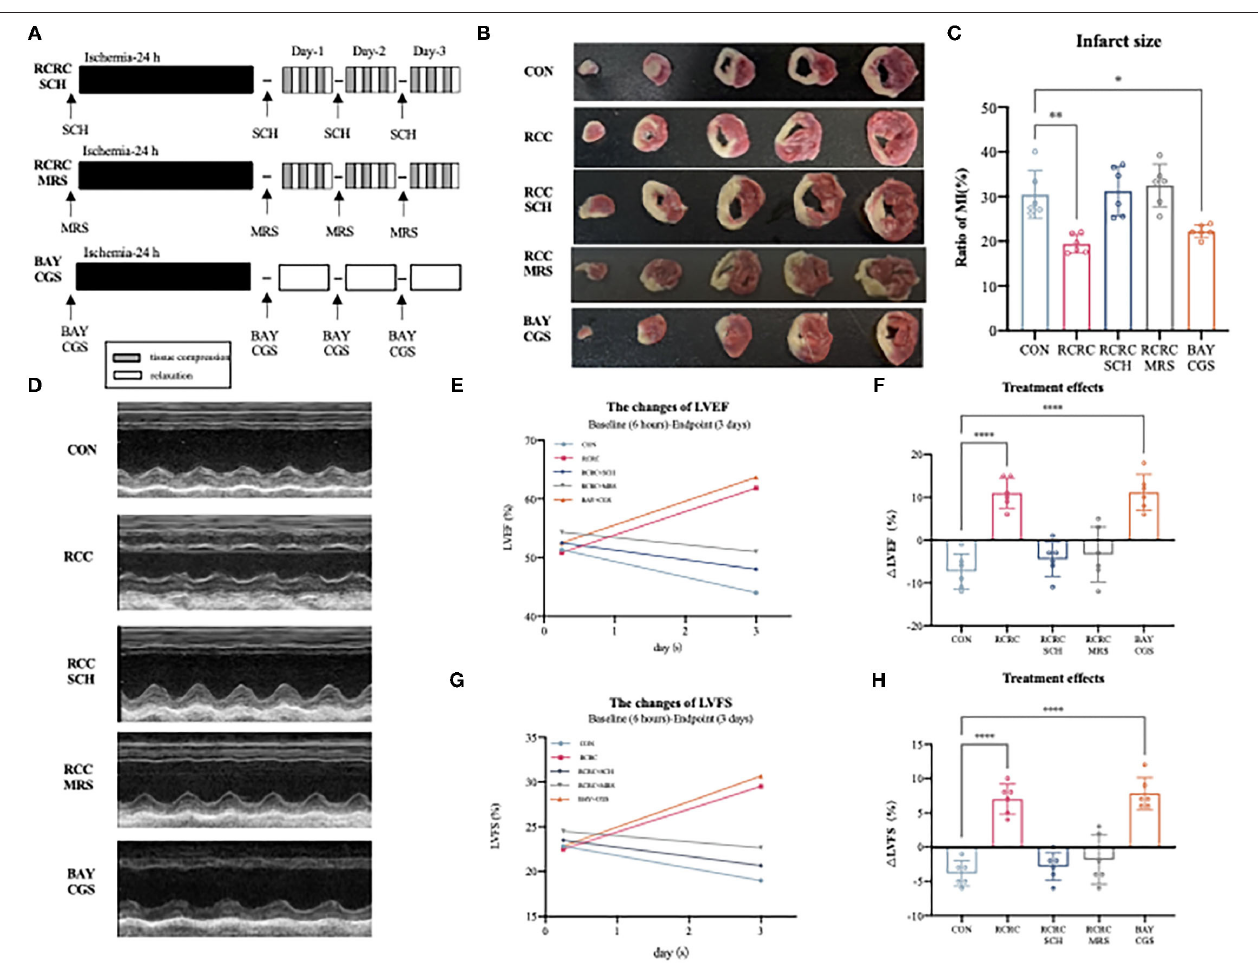
FIGURE 6 | Cardioprotection of remote conditioning by rhythmic compression is lost in SCH or MRS treated rats and mimicked by BAY and CGS treatment. (A) Schematic diagram of the experimental design. RCRC group were treated with the selective A2a antagonist SCH 58261, the selective A2b antagonist MRS 1706; CON group treated with the selective A2a agonist CGS21680 and the selective agonist A2b agonist BAY 60-6583. (B,C) TTC staining representing infarct area on multiples slices of an infarct rat heart and quantitative analyses of infarct size after 3 days of remote conditioning in combination with A2a and A2b receptor blockage and activation, N = 6. (D–H) Representative M-mode echocardiographic images showing LV wall motion of the hearts, the treatment effect was calculated as the changes of LVEFs and LVFSs from baseline to endpoint in combination with A2a and A2b receptor blockage and activation. All values represent as means ± SD. N = 6. * p < 0.05, ** p < 0.01, **** p < 0.0001 vs.